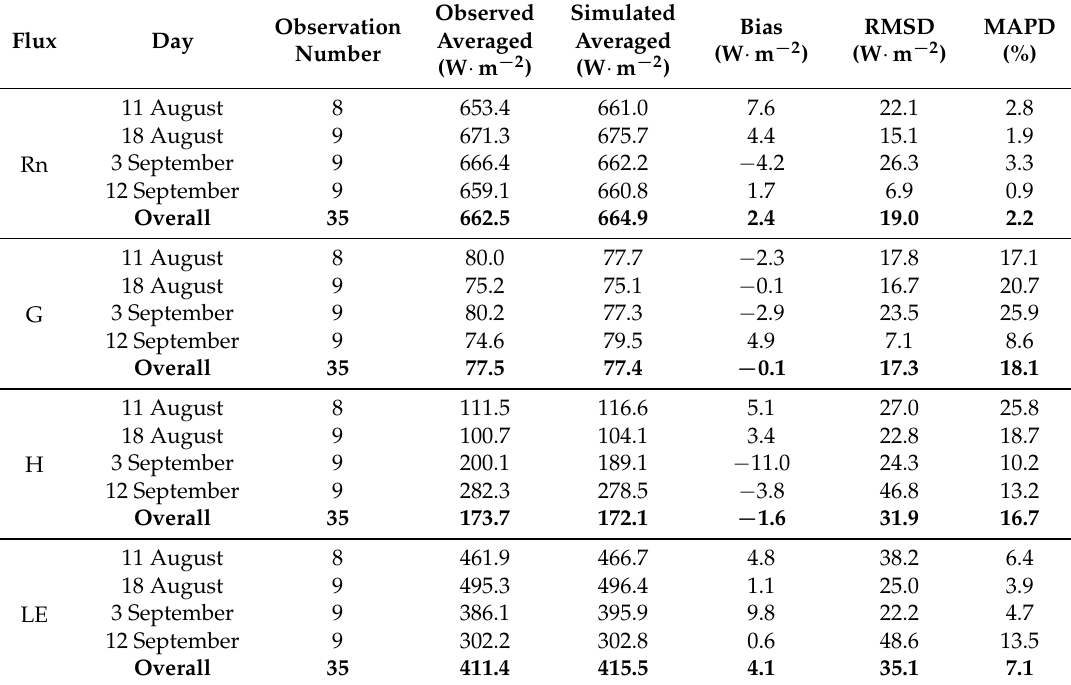
Table 1. Statistics of the improved TSEB model-derived surface energy